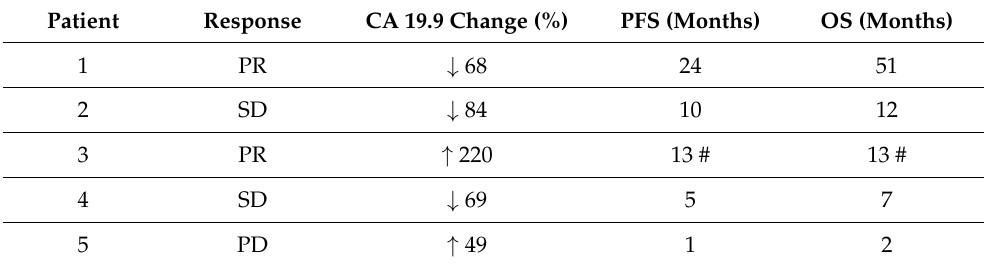
Table 3. Patient’s outcome results.